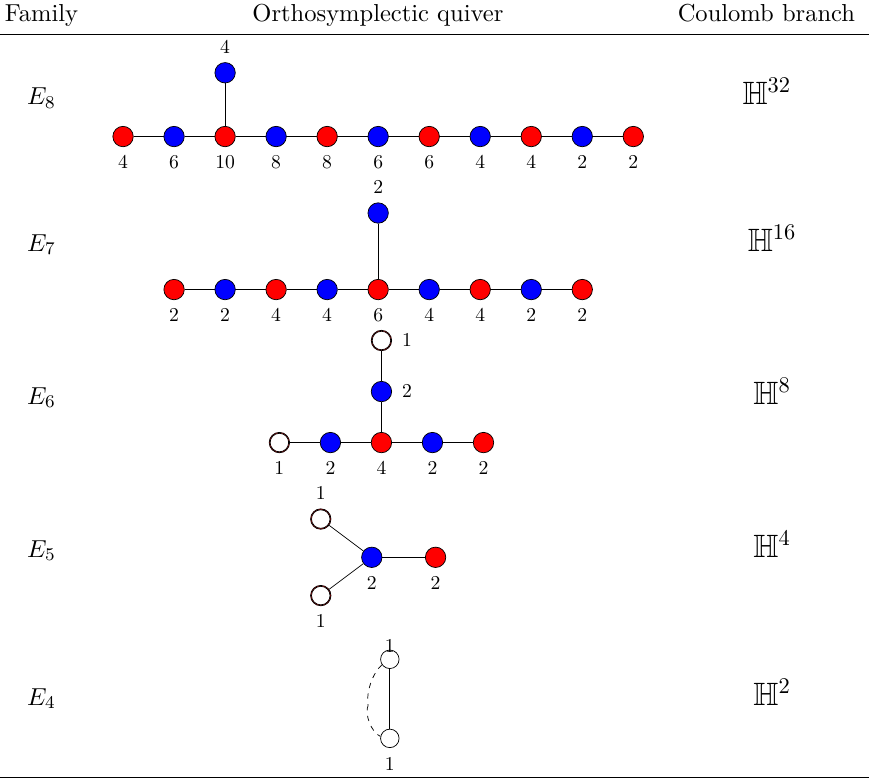
Table 6. The k = 0 members of the E n × E n family of table 4 for 4 ≤ n ≤ 8 . These quivers are magnetic quivers for free hypermultiplets such that Coulomb branches are flat spaces. The Coulomb branch Hilbert series are given by PE [2( n − 3) t ]